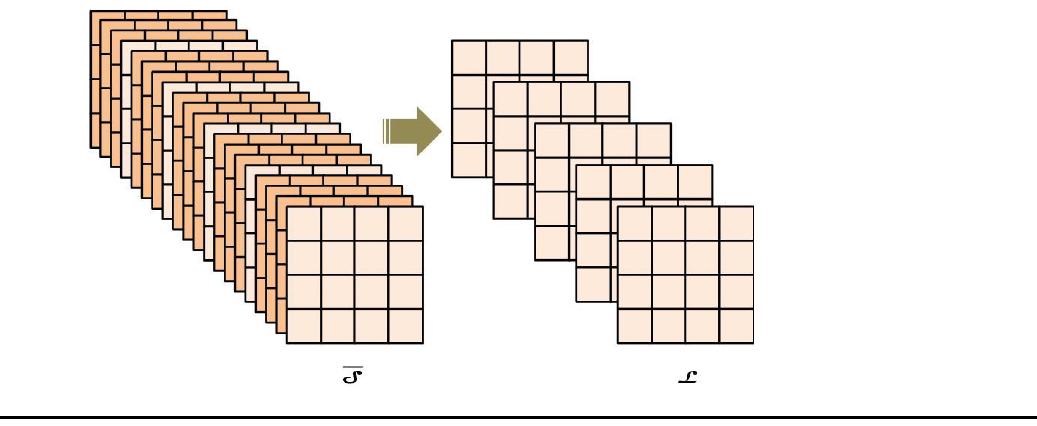
Algorithm 2 Data